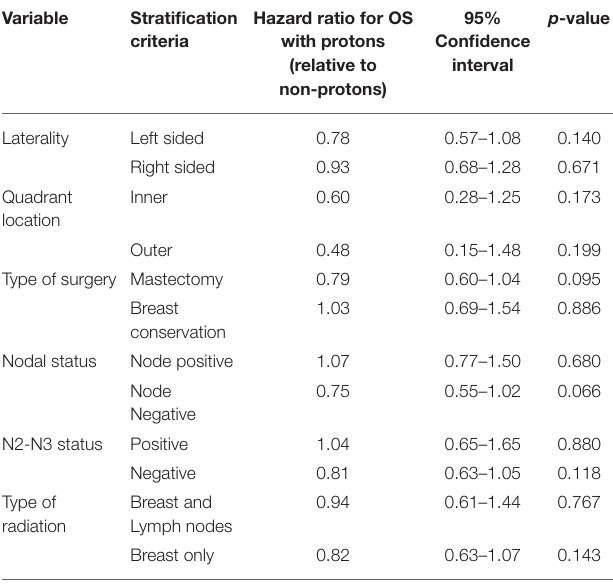
TABLE 3 | Multi-variate analysis examining the effect of protons, relative to non-protons, on overall survival.